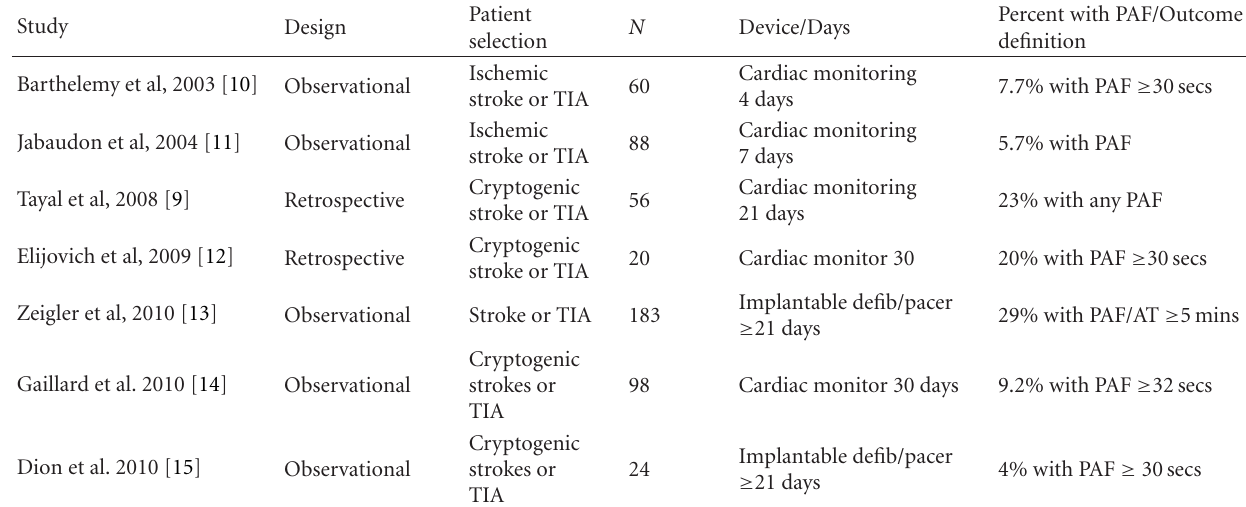
Table 2: Previous studies evaluating prolonged cardiac monitoring.